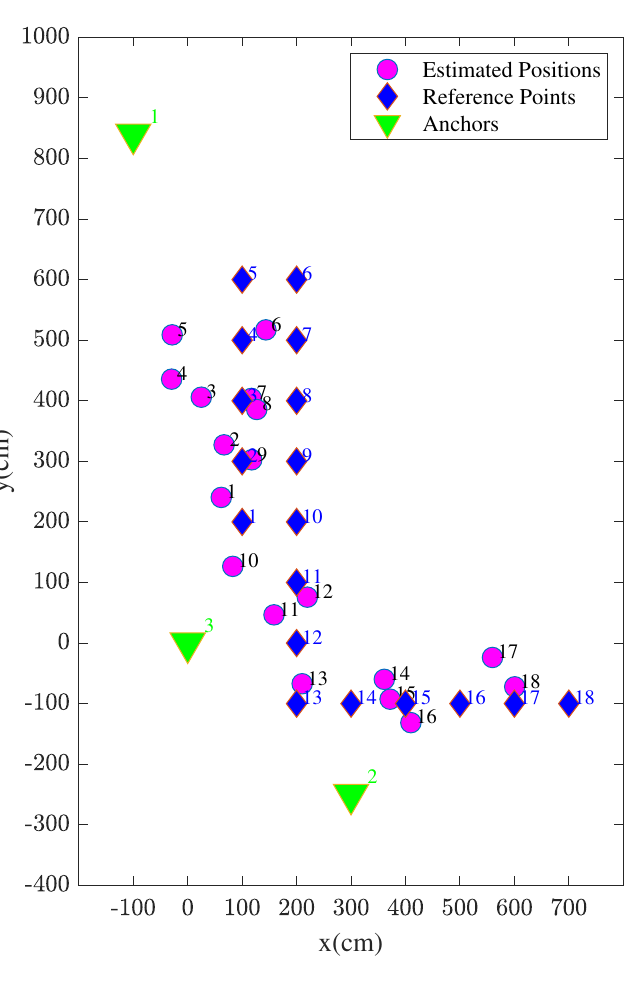
Figure 20. UE positions estimated using the proposed